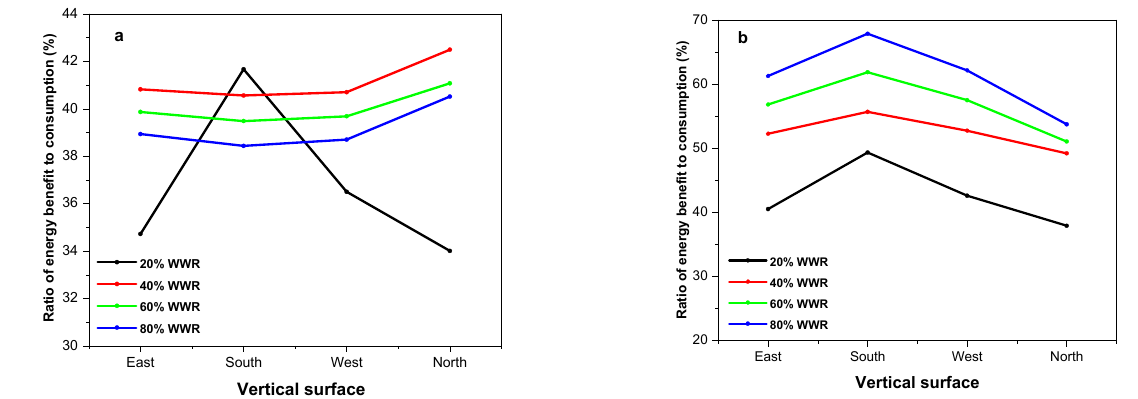
Figure 18. ( a ) BIPV output excluded. ( b ) BIPV output included.